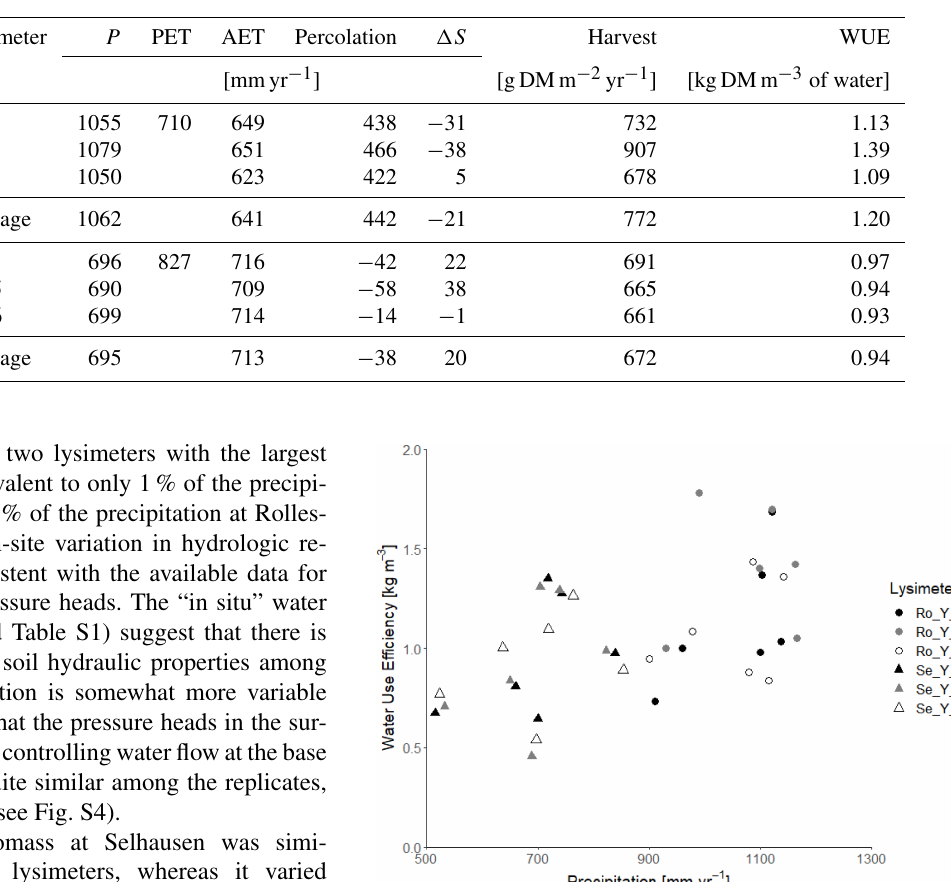
Table 2. Measured water balance, harvested biomass and water use efficiency for the lysimeters (annual averages for the period 2013–2018; P is precipitation, PET is potential evapotranspiration calculated with the FAO Penman–Monteith method, AET is actual evapotranspiration, (cid:49)S is the change of water storage calculated as P − AET − percolation and WUE is water use efficiency defined as harvested biomass (harvest) divided by AET).